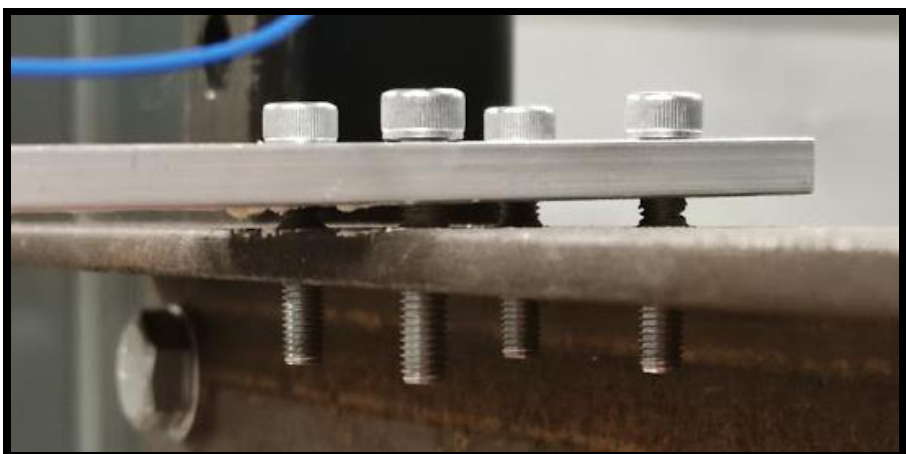
Figure 5. Loosened bolts at cantilever fixed end.